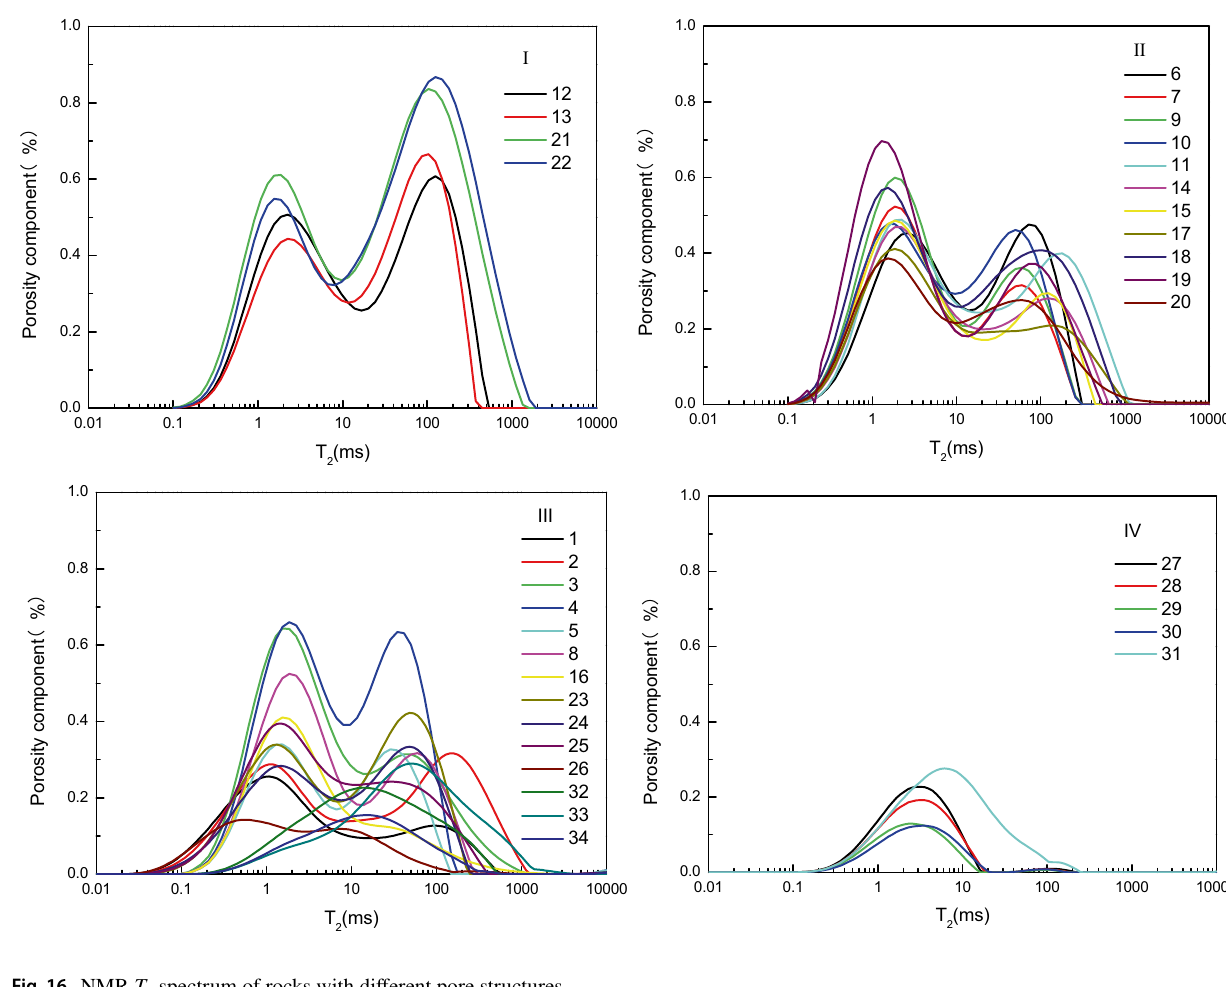
Fig. 16 NMR T 2 spectrum of rocks with different pore structures